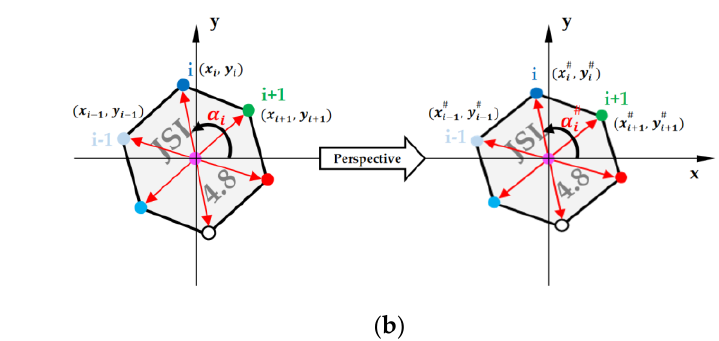
Figure 15. Schematic diagram of image perspective distortion caused by camera angle. ( a ) Geometric principle of perspective distortion; ( b ) Coordinate changes in corner points after perspective distortion.